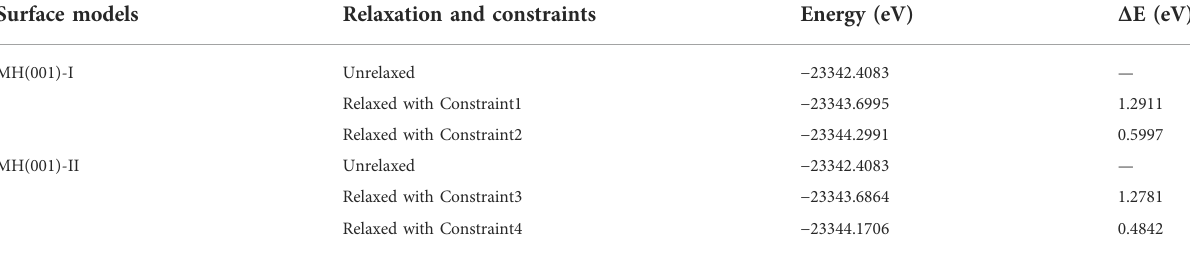
between optimized models with Constraint1 deviation Constraint4 conditions